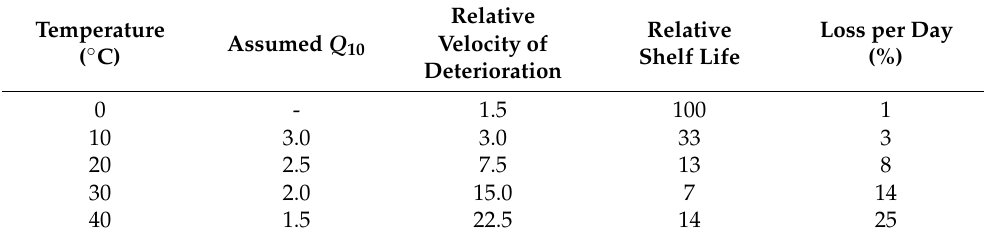
Table 2. Effect of temperature on Q 10 and deterioration of horticultural products